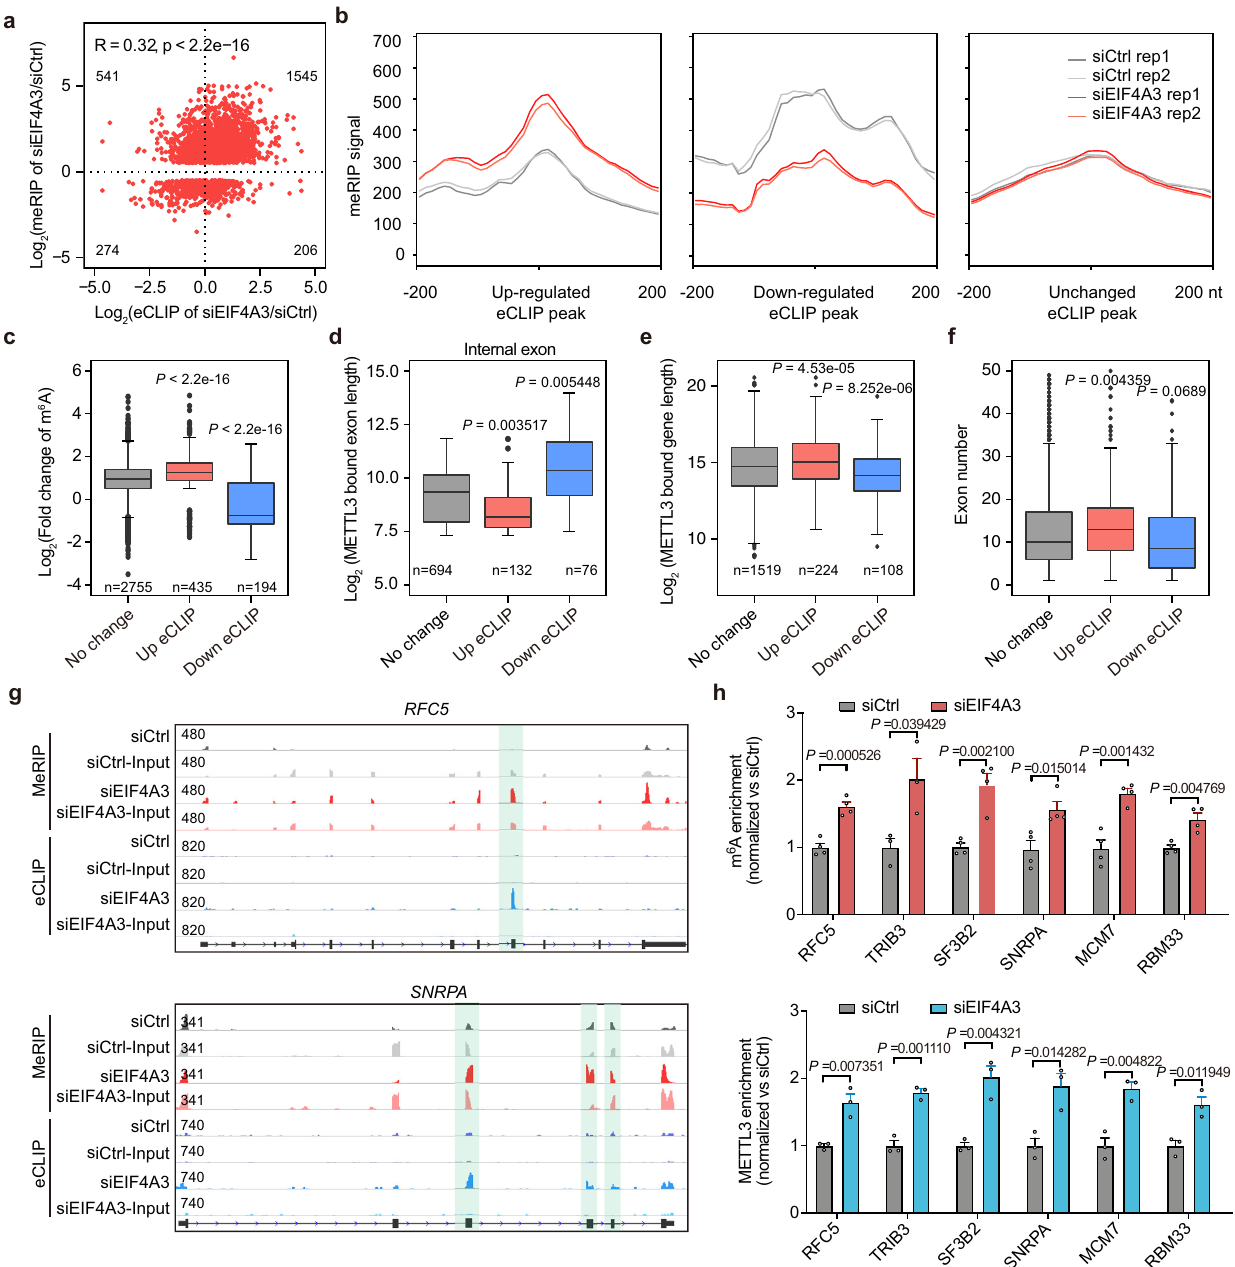
Fig. 3 | EIF4A3 locally inhibits METTL3 binding and m 6 A modi fi cation. a Correlation between m 6 A fold change and METTL3 binding fold change upon EIF4A3 knockdown. Correlation coef fi cient (r) and P value was calculated by Pearson ’ scorrelationanalysis. b AveragedistributionofMeRIP-seqsignalisshown, aligned around increased, decreased, and unchanged METTL3 binding peaks. c Boxplot showing the fold change of m 6 A enrichment on METTL3 binding peaks upon EIF4A3 depletion. METTL3 binding peaks are divided into three groups: no change, up regulated and down regulated upon EIF4A3 KD. Solid line represents median,withwhiskersindicatingminimumtomaximumvalues.Statisticalanalyses, unpairedtwo-tailedStudent ’ s t -test. d Thelengthofinternalexonswithunchanged, increased or decreased METTL3 binding peaks. Solid line represents median, with whiskers indicating minimum to maximum values. Statistical analyses, unpaired